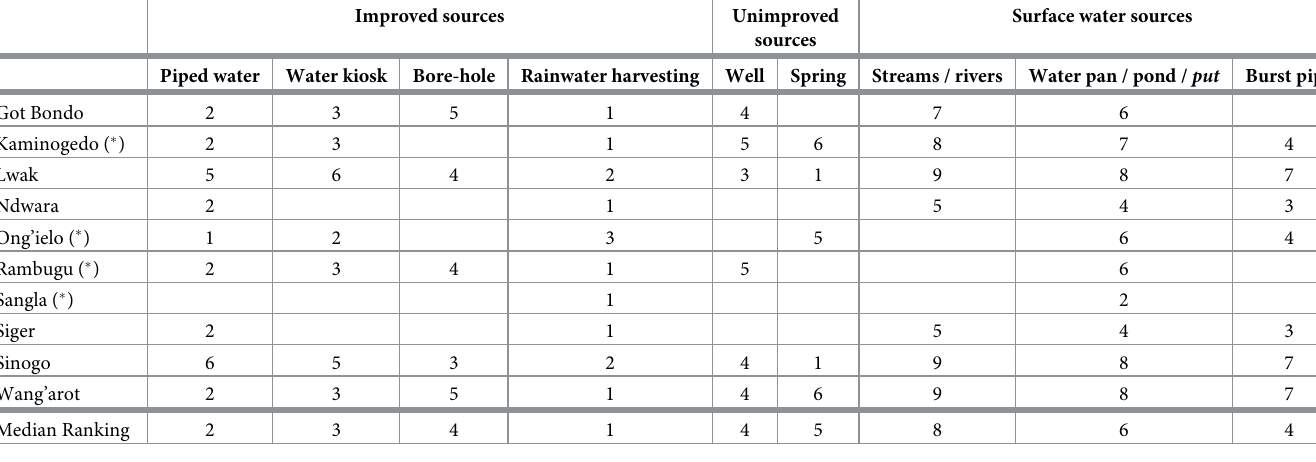
Table 2. Water source safety rankings in ten villages in Siaya County, Kenya, derived from participatory